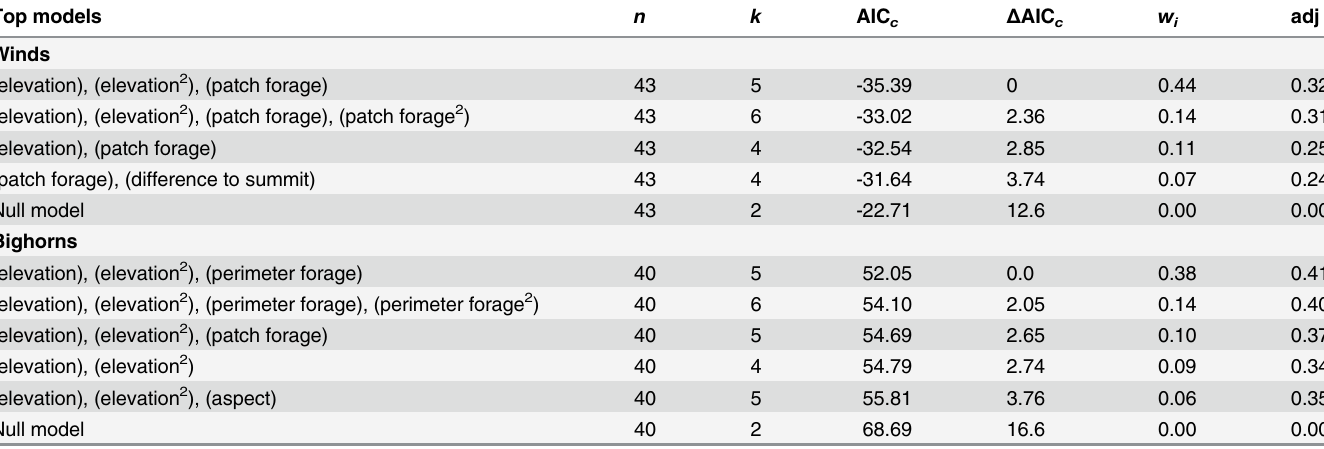
Models within 4 Δ AIC c units of the top model are shown. Model weights ( w i ) were calculated for each model based on the number of parameters ( k ) and number of sites sampled ( n ). See Tables A and B in S1 File for full model